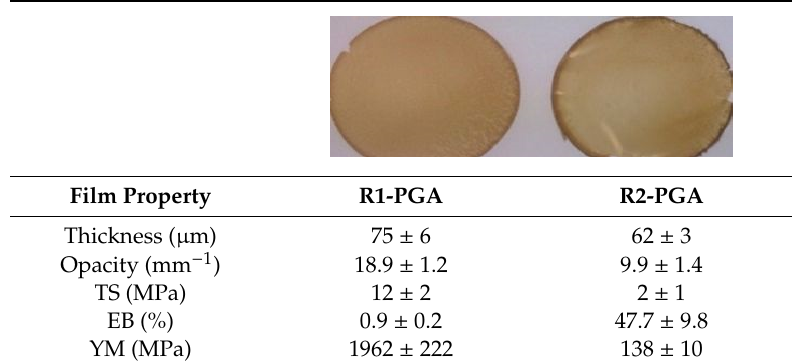
Table 5. Images and properties of films obtained at pH 3.5 with 800 mg of PGA contained in R1 and R2 samples. Experimental details are given in the text.